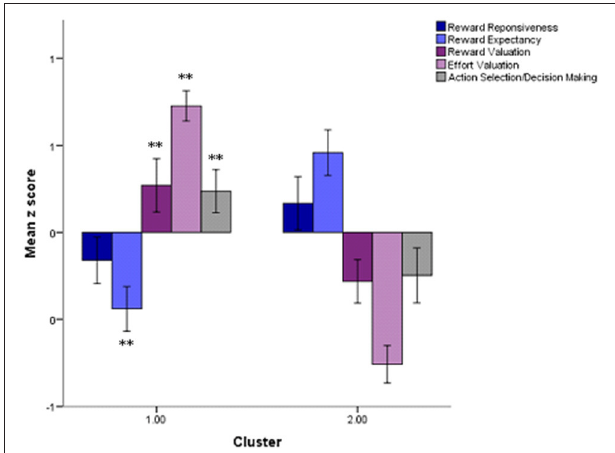
FIGURE 6 | Motivation performance profiles across clusters. Significant differences are denoted by ** p < 0.01. Error bars represent standard error of the mean.